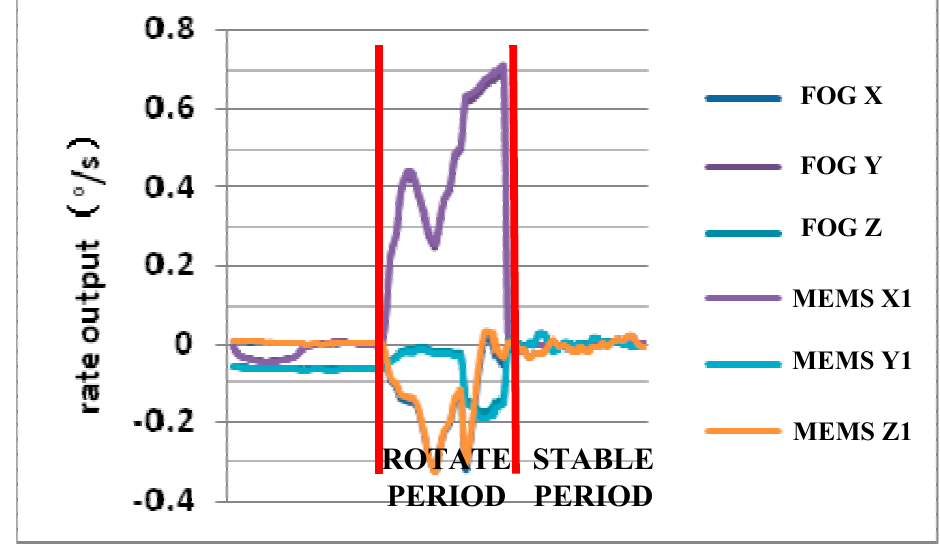
Figure 10. In-orbit data comparison between MEMS IMU and FOG unit.